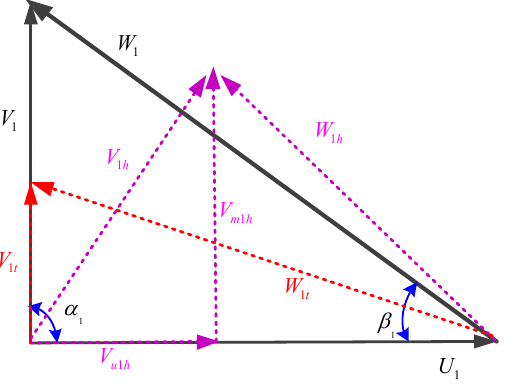
Figure 18. The velocity triangle of the impeller inlet flow field structure.